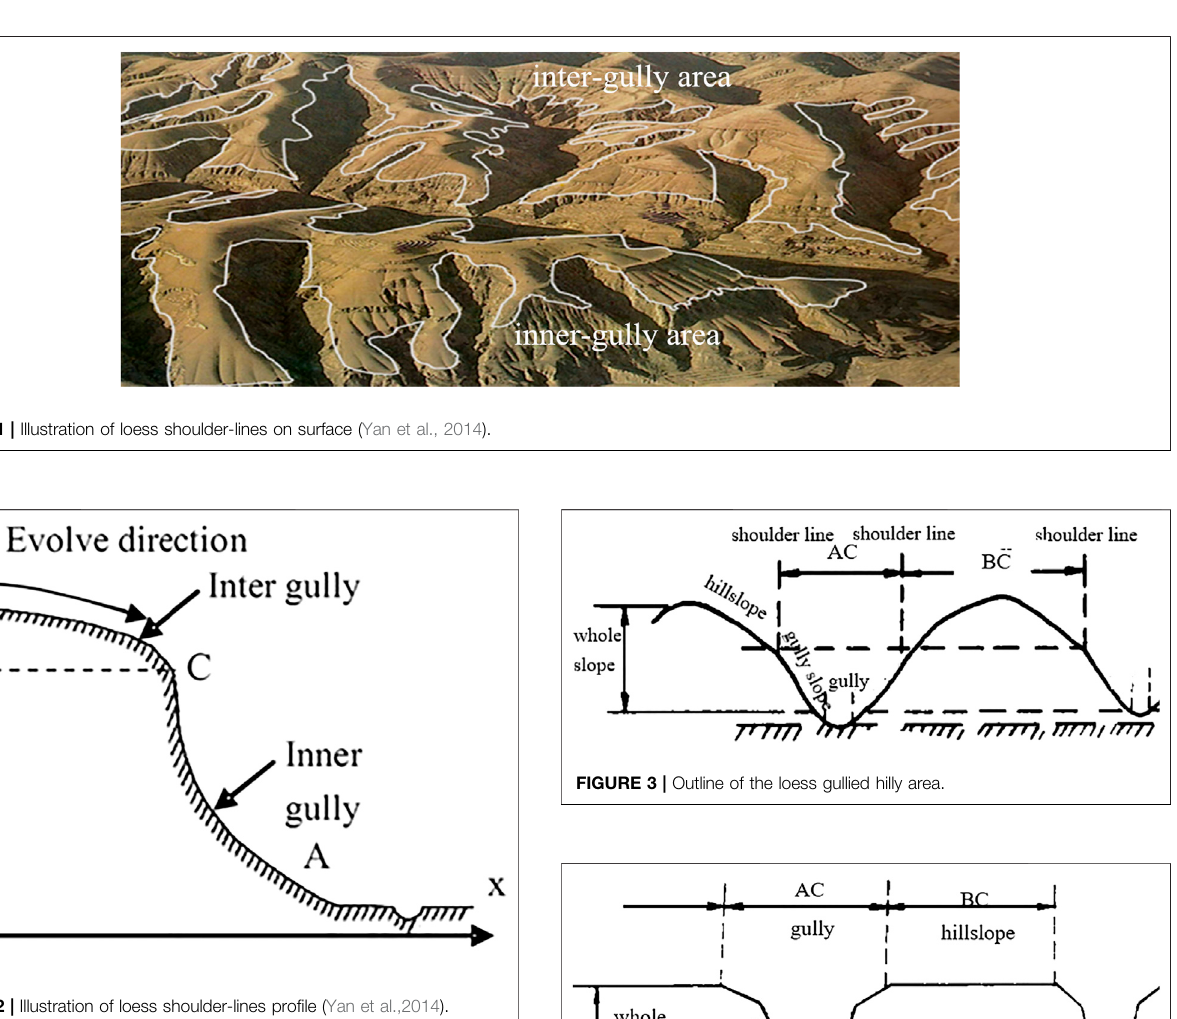
FIGURE 2 | Illustration of loess shoulder-lines pro fi le (Yan et al.,2014).